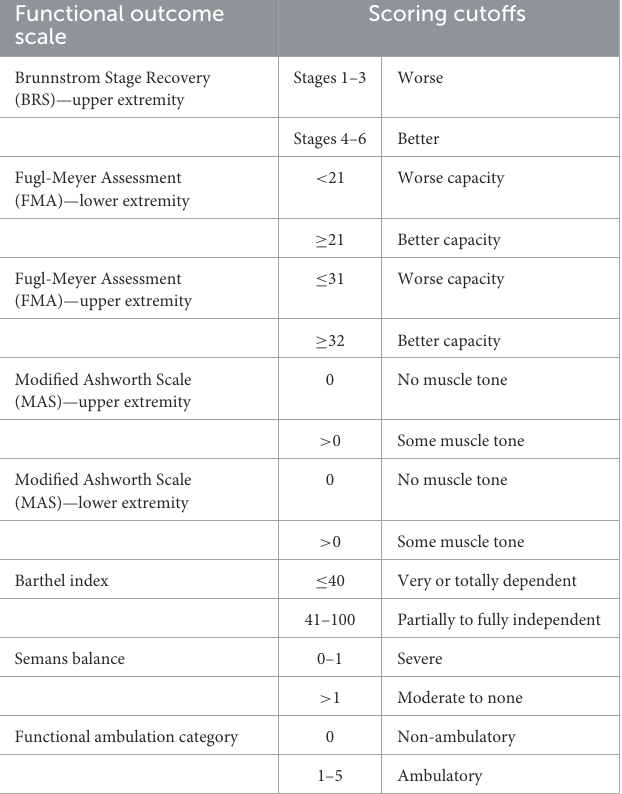
TABLE 1 Cutoffs for each functional outcome scale utilized in the machine learning models. Functional outcome